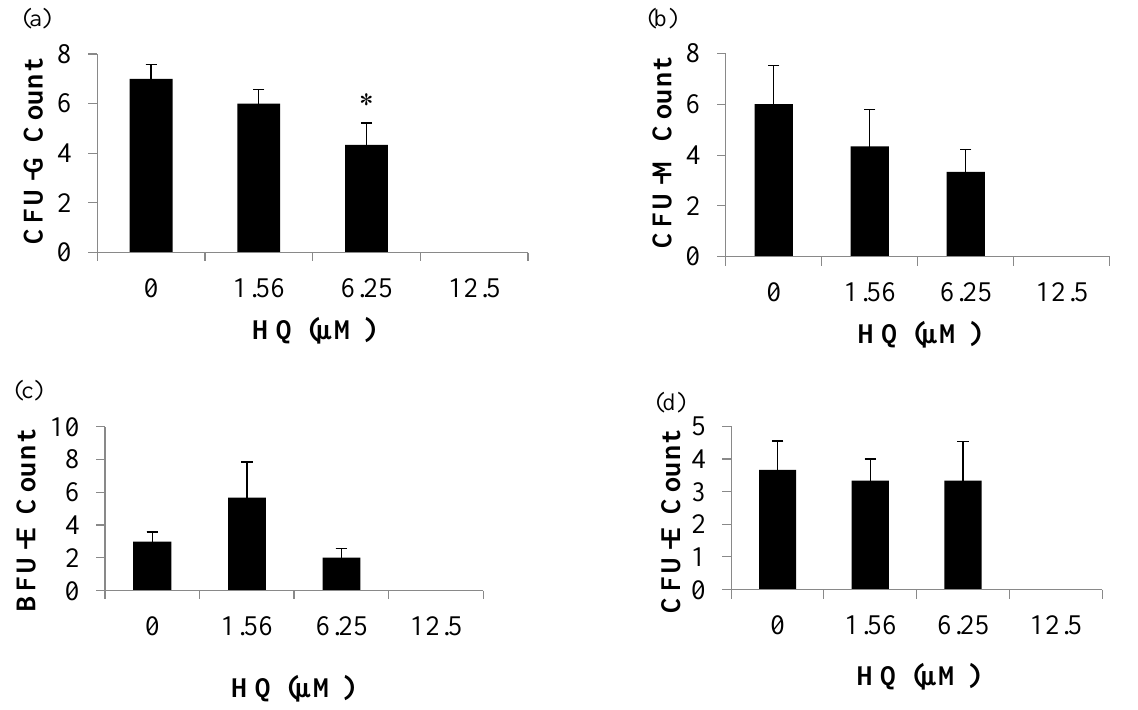
Figure. 5 Effect of HQ on the clonogenicity of single-lineages myeloid-committed progenitors was determined according to the colony counts of (a) CFU-granulocyte (CFU-G), (b) CFU-macrophage (CFU-M), (c) Burst-forming unit erythroid (BFU-E) and (d) CFU-erythroid. The mouse bone marrow cells were exposed to HQ for 24 h at 1.56 µM, 6.25 µM and 12.5 µM. The number of CFUs was counted and classified morphologically under inverted microscope after 14 days of culture. Data are presented as the mean ± S.E.M. (n=3). * p < 0.05 as compared to non-treated control